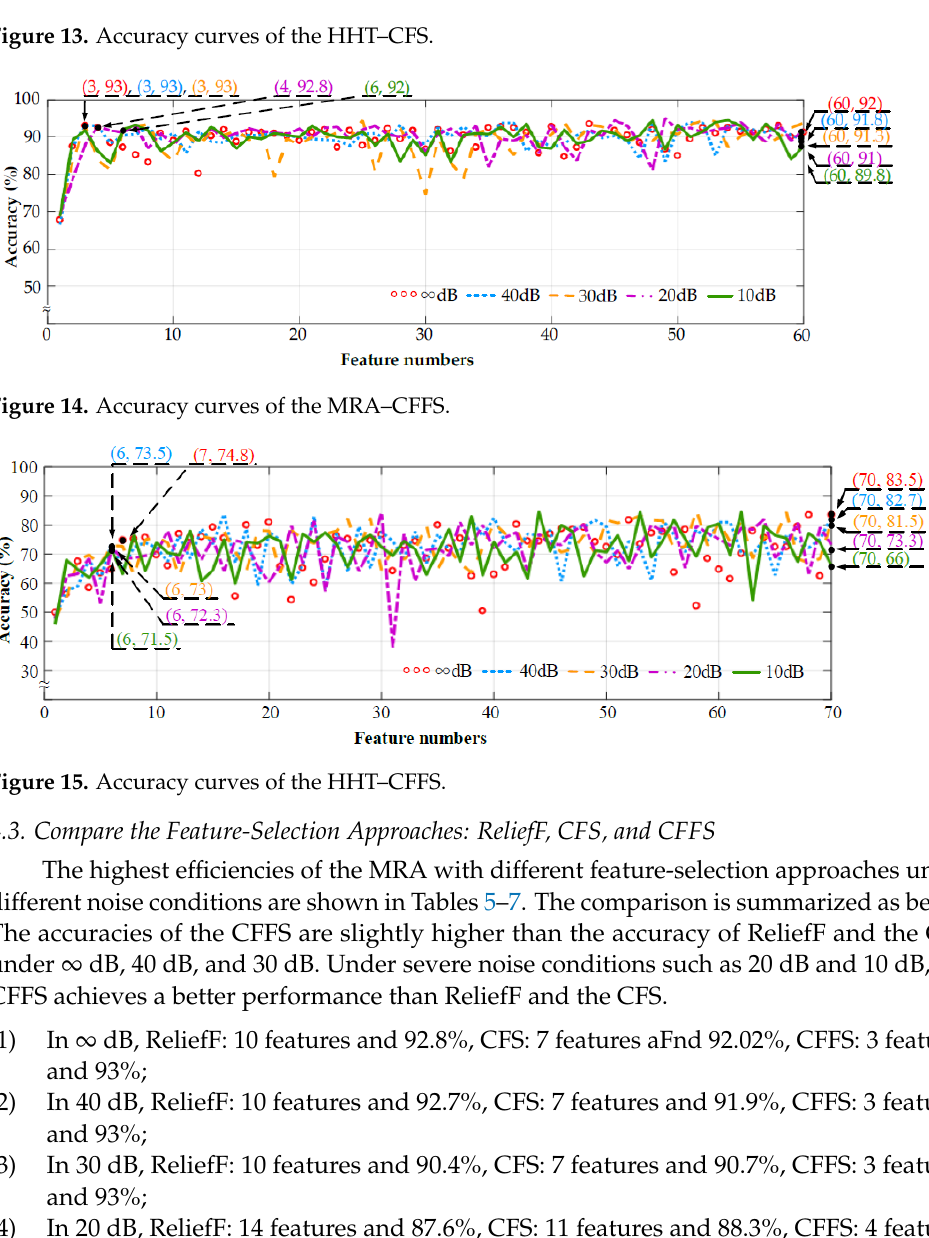
Table 5. Result of the MRA–ReliefF.